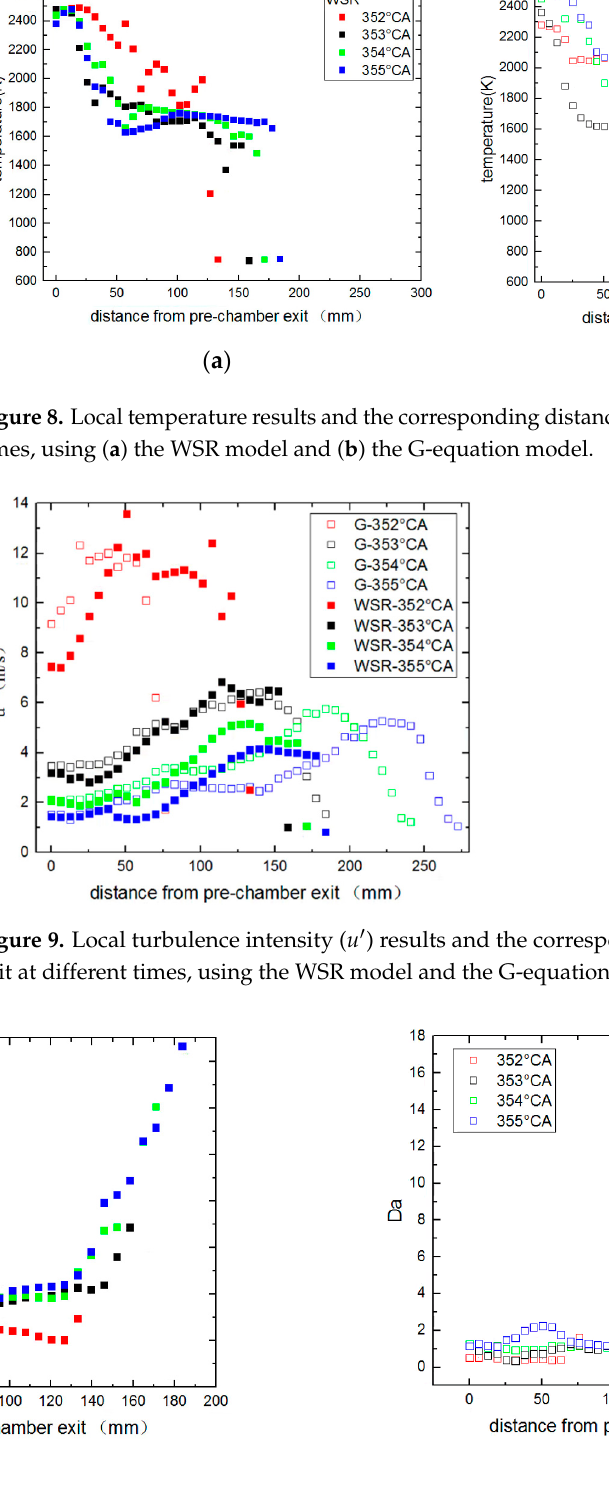
Figure 10. Local Damkohler number ( Da ) results and the corresponding distance from pre-chamber exit at different times, using ( a ) the WSR model and ( b ) the G-equation model.